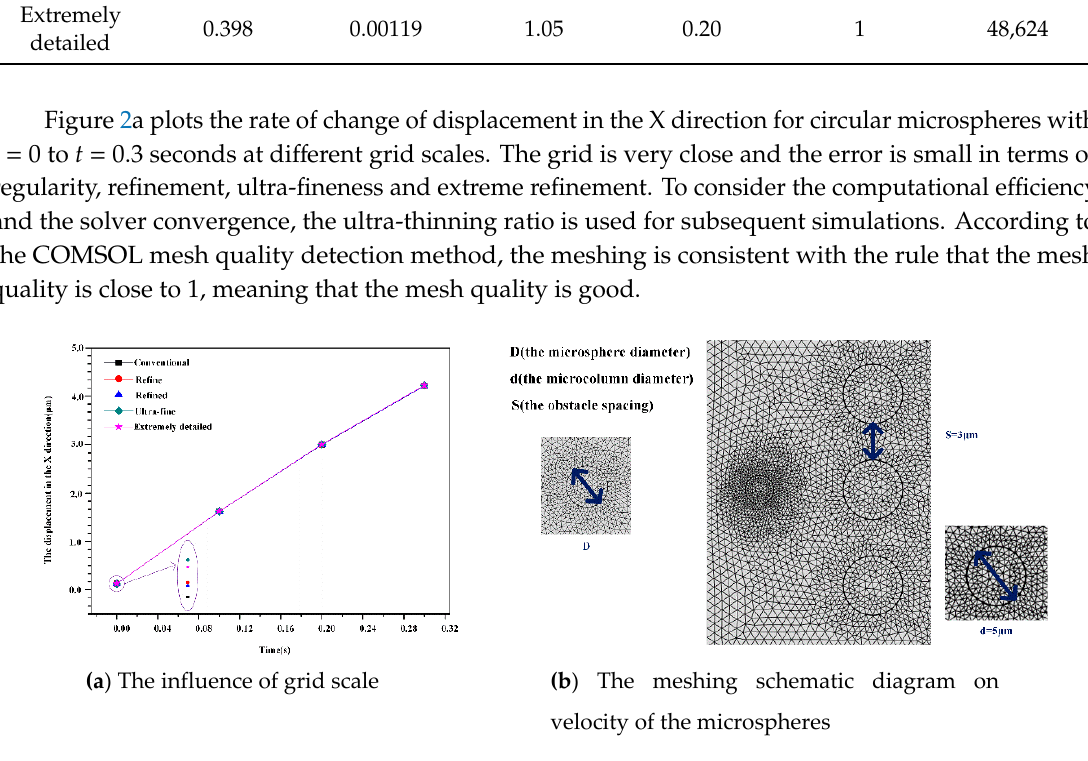
Figure 2. Grid-independent verification ( a ) describes the variation of the velocity of the microspheres along the x-direction at five different grid scales, and ( b ) plots the ultra-fine grids used for the simulation of this number of times.